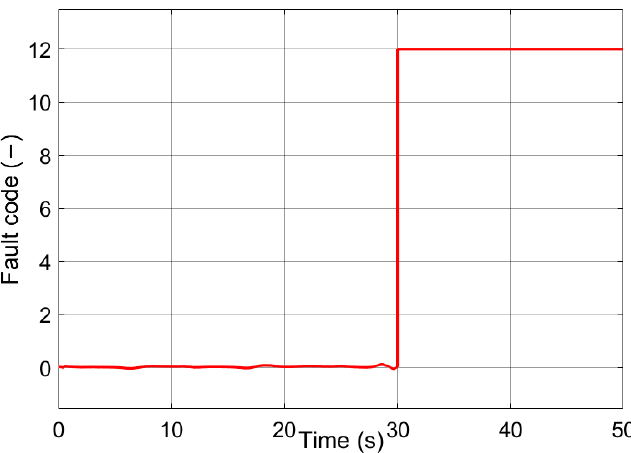
Figure 7. Left rear wheel speed sensor signal (Blue line: sensor signal with no fault; red dotted line: sensor signal with a total loss fault).